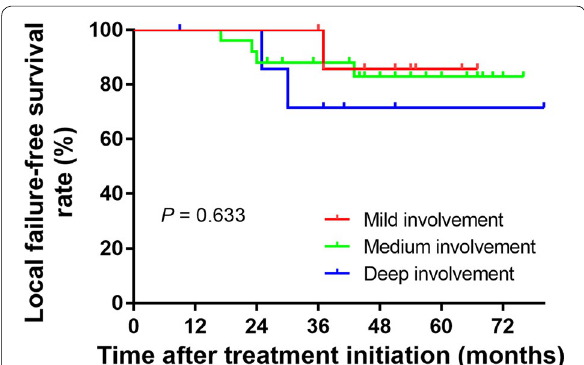
Fig. 2 Effect of different intracranial extension levels on local failure‑ free survival. Kaplan–Meier curves compared with log‑rank test showed no significant differences in terms of local failure‑free survival among T4 nasopharyngeal carcinoma patients with mild, medium, and deep involvement